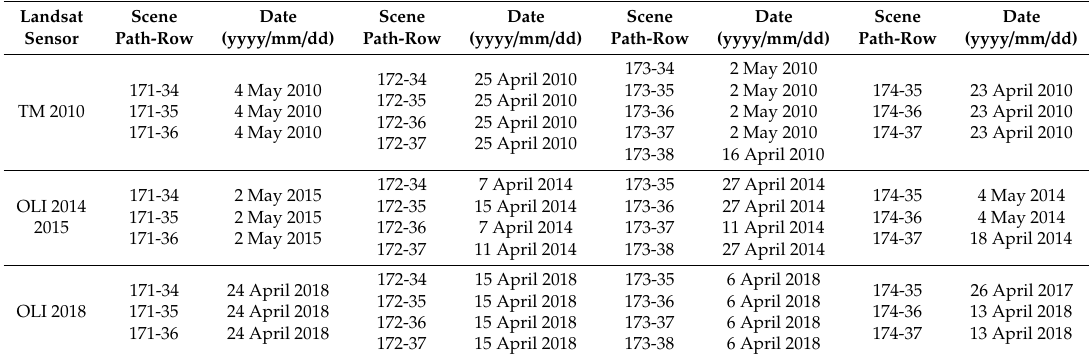
Table 1. Landsat images acquired for the land-use / land change (LULC) classification in Syria. Landsat Scene Date Scene Date Scene Date Scene Date Sensor Path-Row (yyyy / mm / dd) Path-Row (yyyy / mm / dd) Path-Row (yyyy / mm / dd) Path-Row (yyyy / mm /